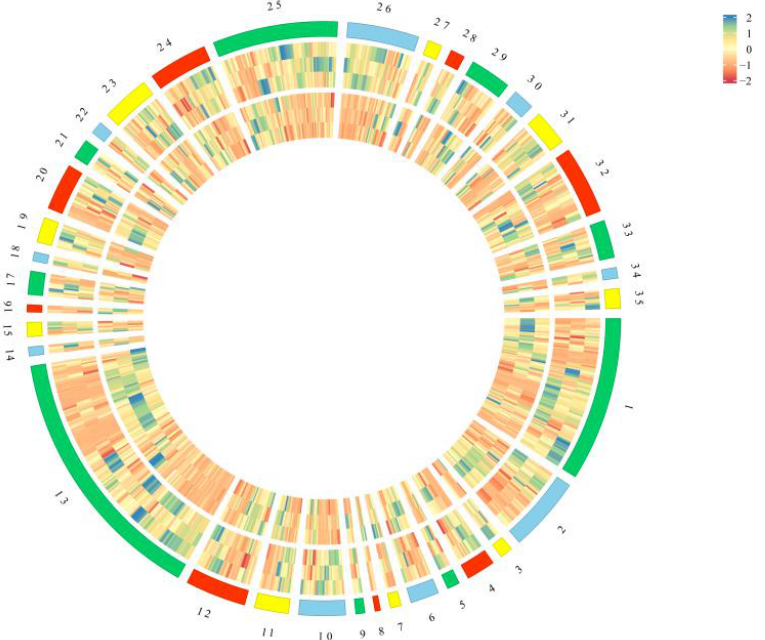
Figure 2. The stigmas and petals of saffron ( Crocus sativus L.). Circular diagram of all metabolites